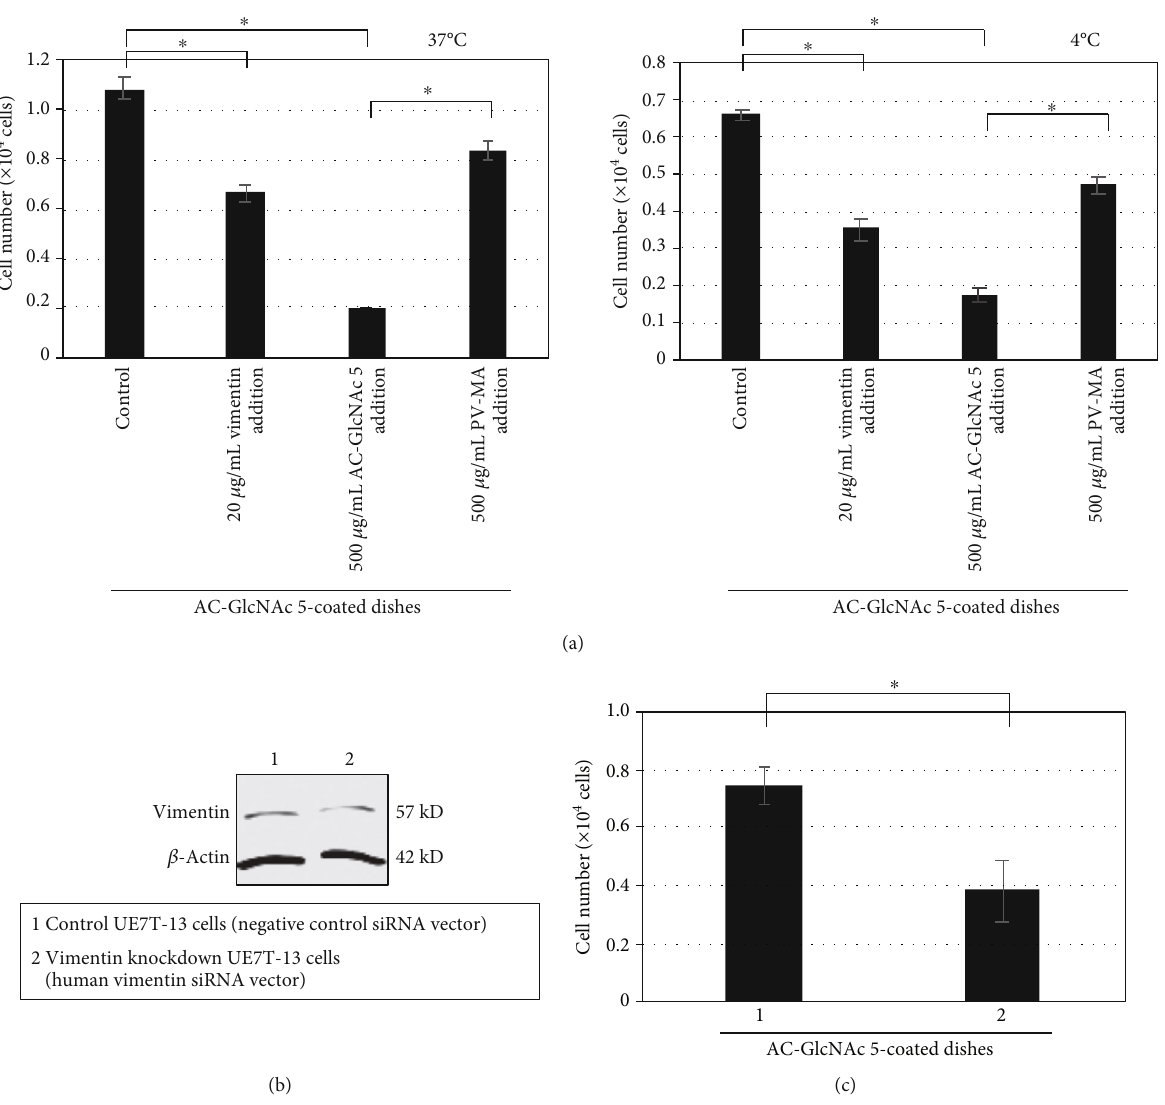
Figure 2: The interaction between cell-surface vimentin and AC-GlcNAc is responsible for the adhesion of UE7T-13 cells to coated dishes. (a) Inhibition of adhesion by AC-GlcNAc at 37 (left) and 4 ° C (right), n = 4 . (b) Expression of vimentin in knockdown and control cells. (c) Inhibition of adhesion by vimentin knockdown. Adherence of vimentin-knockdown and control cells to AC-GlcNAc 5-coated dishes at 4 ° C, n = 5 . ∗ P < 0 : 01